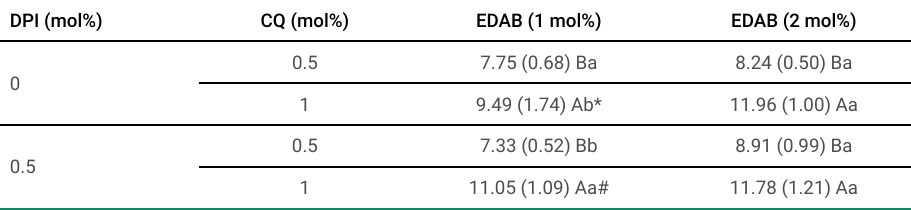
Table 4. Means (standard deviation) of coordinate b*